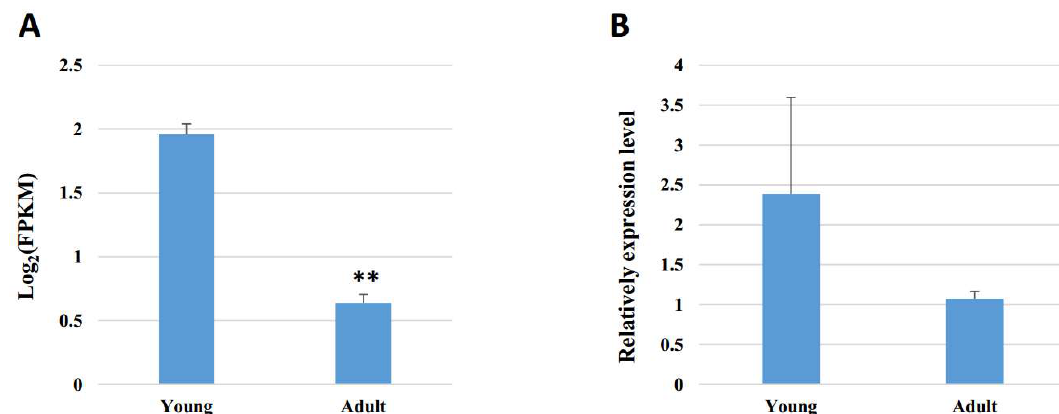
Figure 4. Expression of PRDM16 in young and adult buffalo adipose tissue. ( A ) Expression pattern analyzed by RNA sequencing. ( B ) Expression pattern analyzed by qRT-PCR. Data are presented as the means ± SEMs, n = 3. ** p < 0.01, compared with the young group.